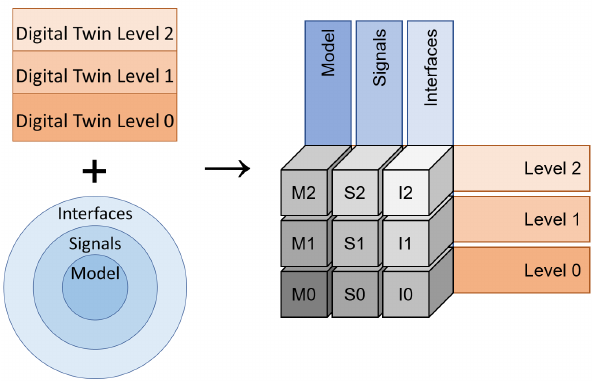
Figure 5. The 9-block concept. [Source: Own